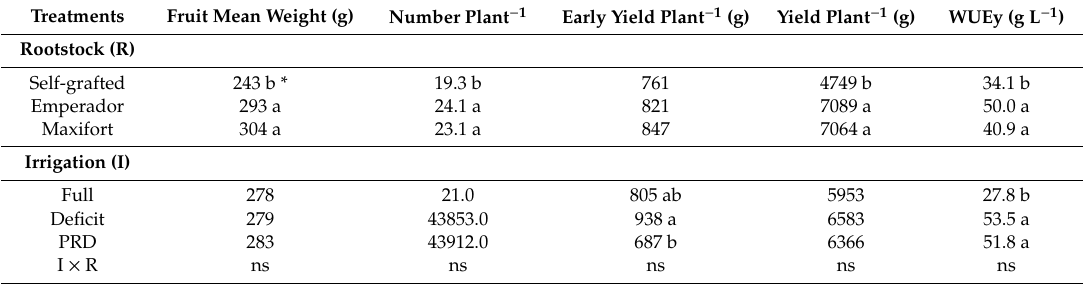
Table 4. Yield parameters and water-use e ffi ciency of grafted tomato plants grown with one stem under three irrigation techniques in the first year of the